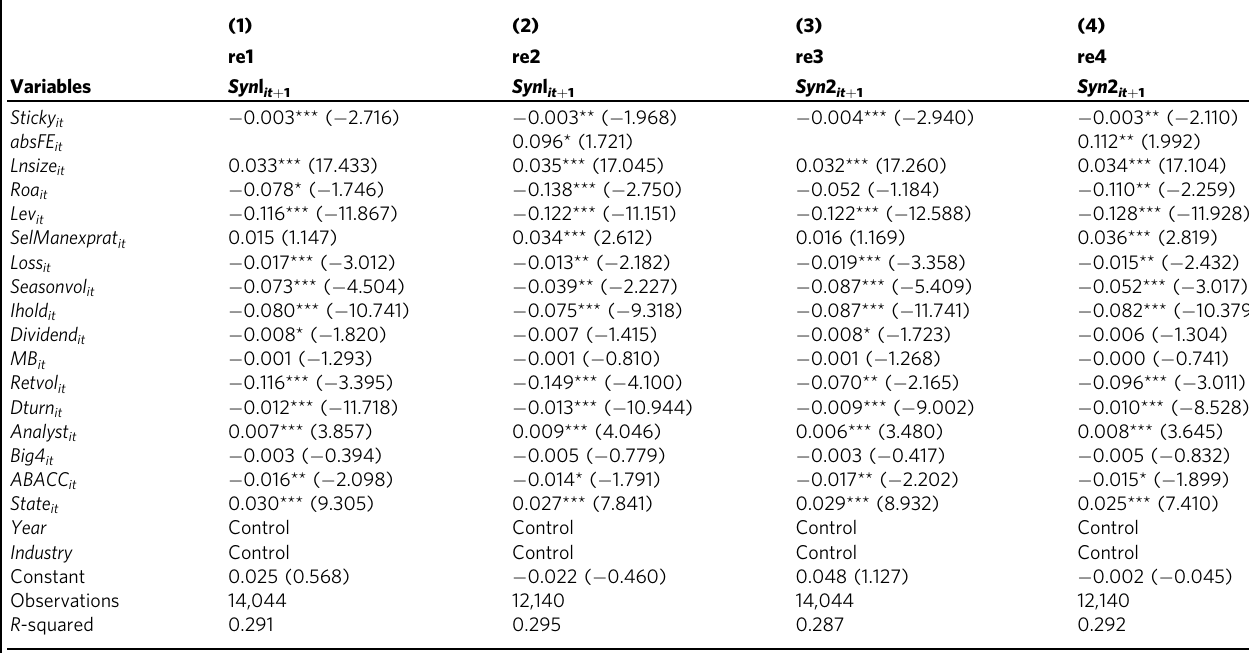
Table 8 The intermediary mechanism test of stock price